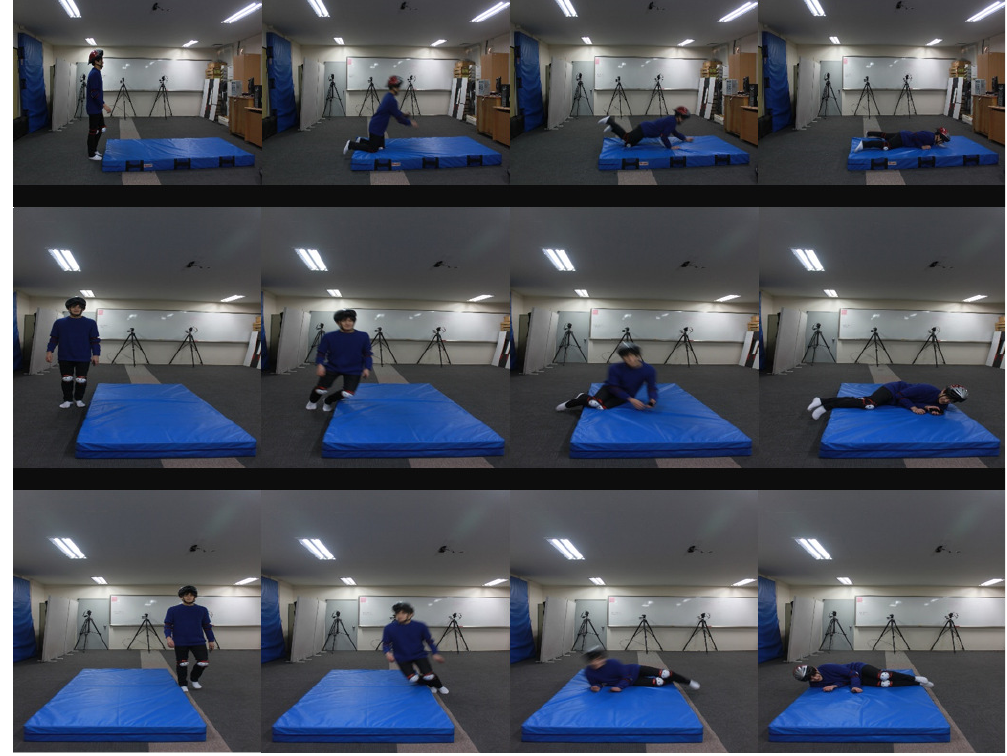
Figure 4. Illustrative